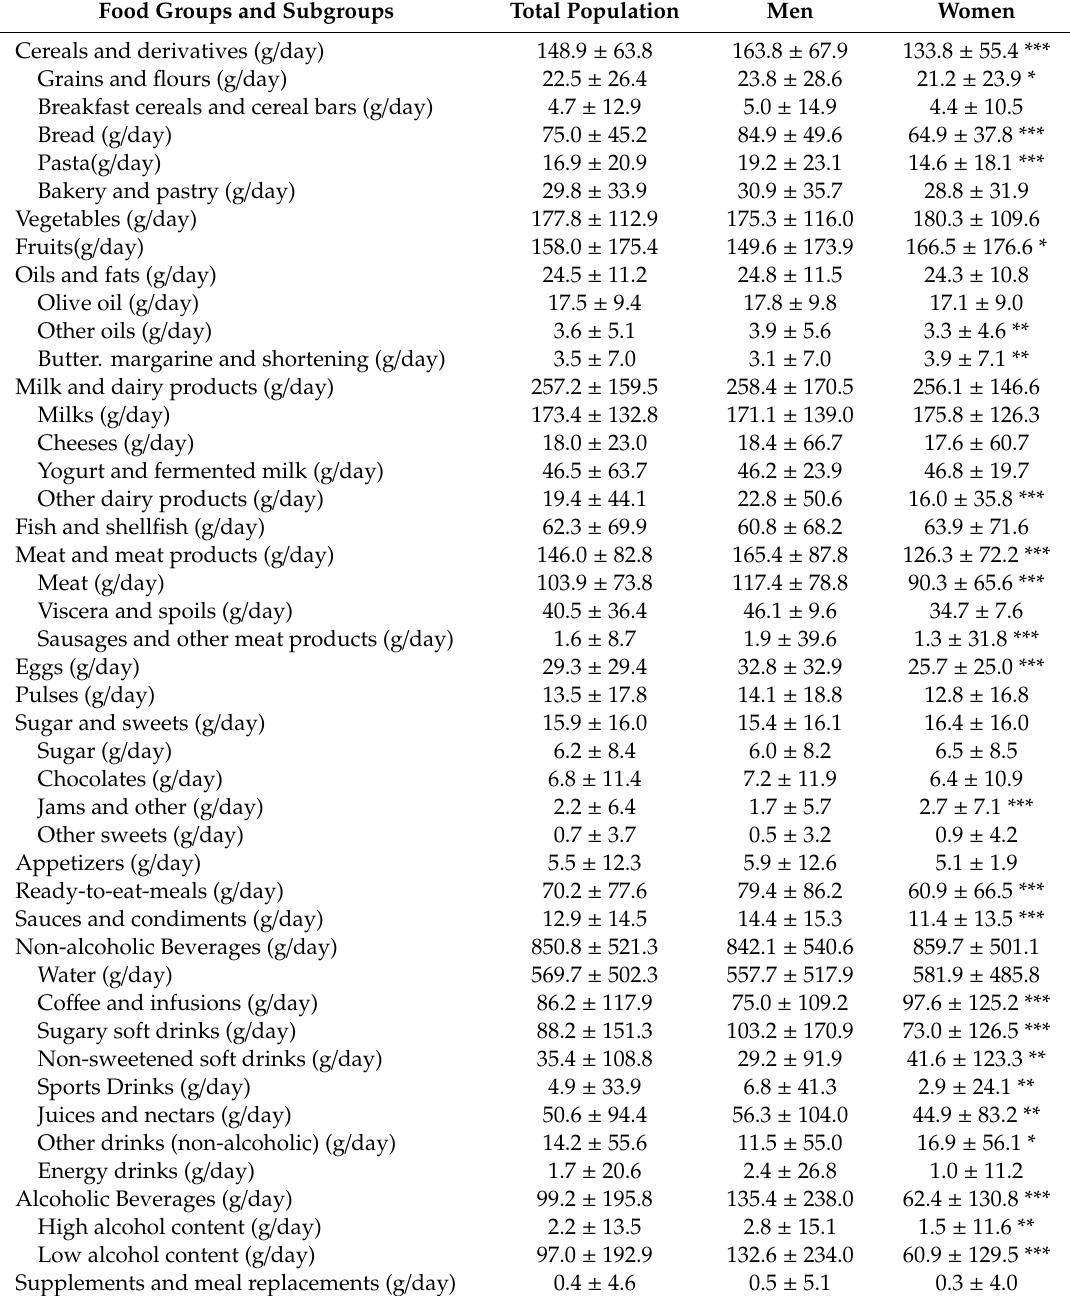
Table 2. Daily food groups and subgroups intake distribution amongst the Spanish ANIBES study population (9–75